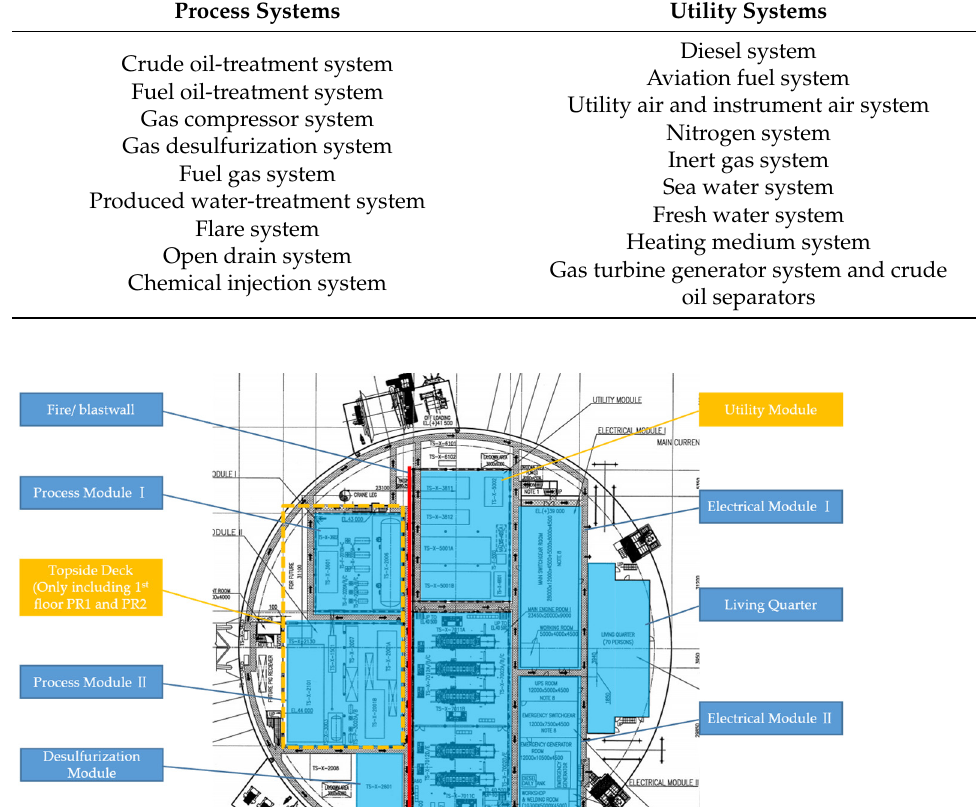
Table 1. Process and utility systems of LH11-1 FPSO